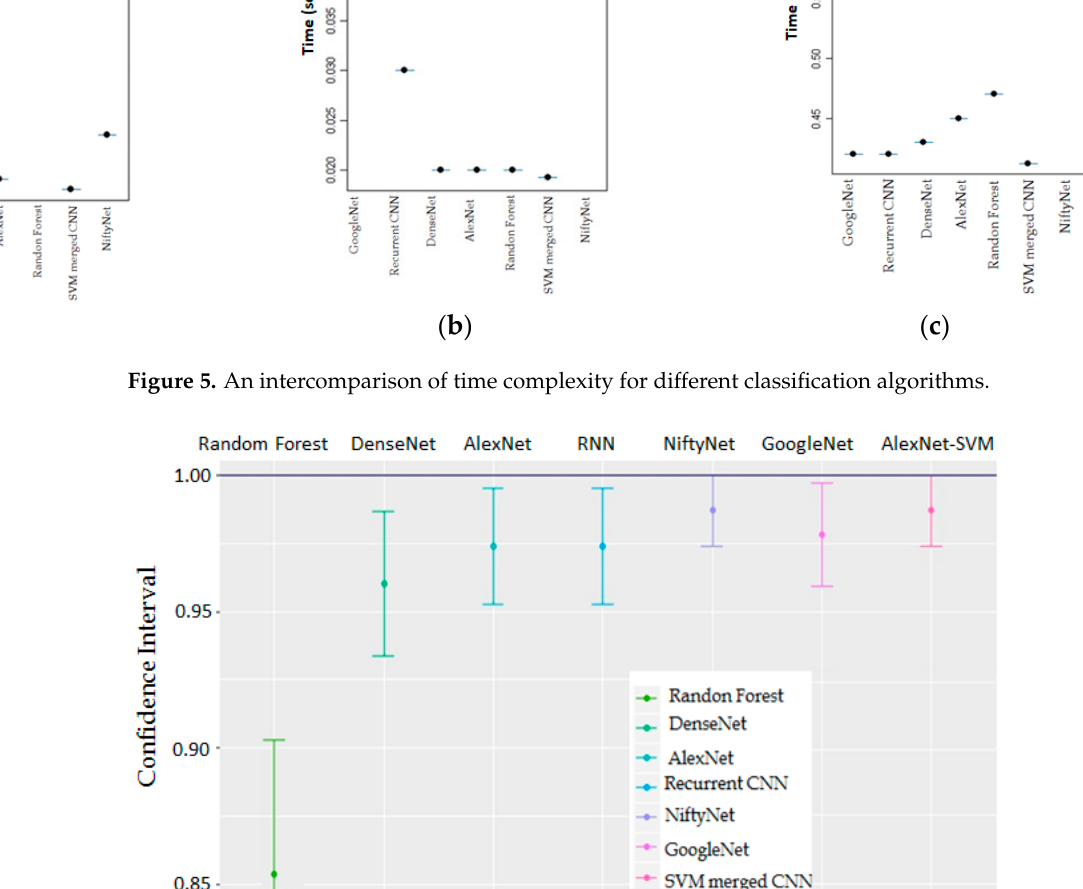
Table 1. Performance indices of the proposed method routine with other leading methods on the same CTG dataset.